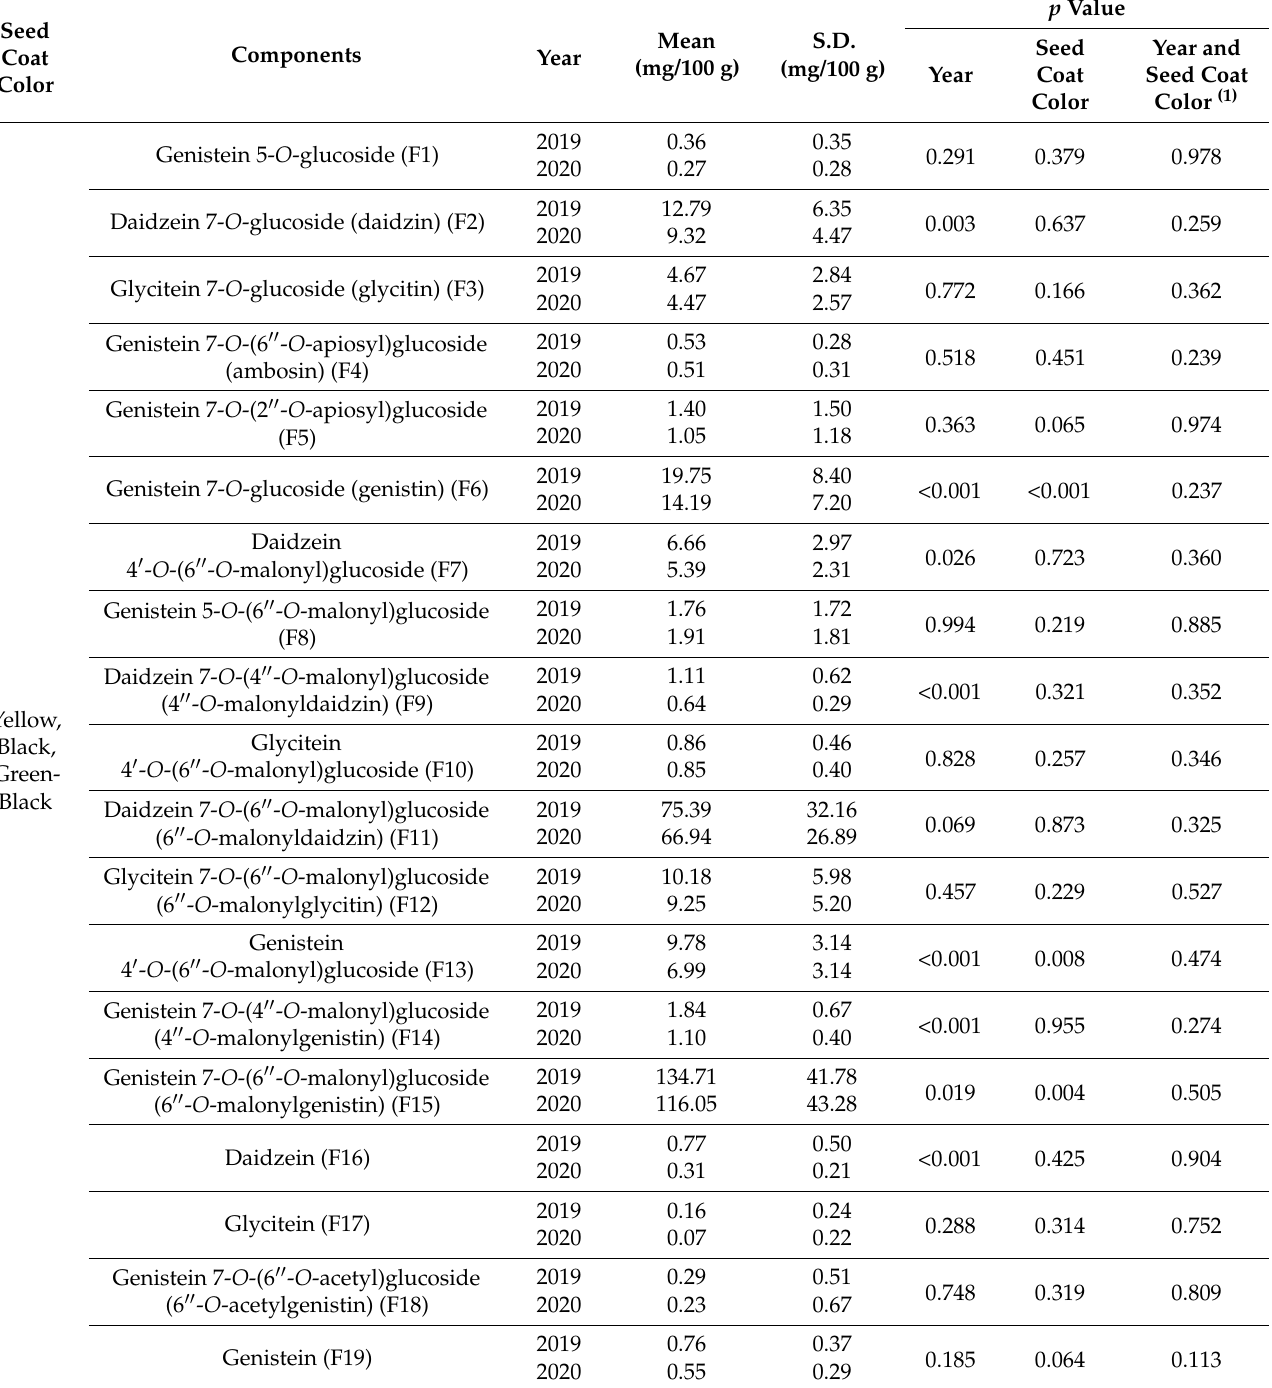
Table 4. ANOVA for the 19 individual isoflavone derivatives and four groups of 48 soybean germplasm in 2019 and